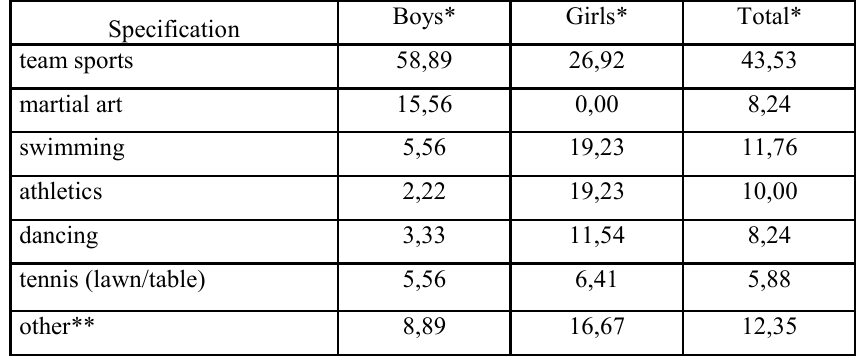
Table. 5. Sport disciplines taken up by the respondents